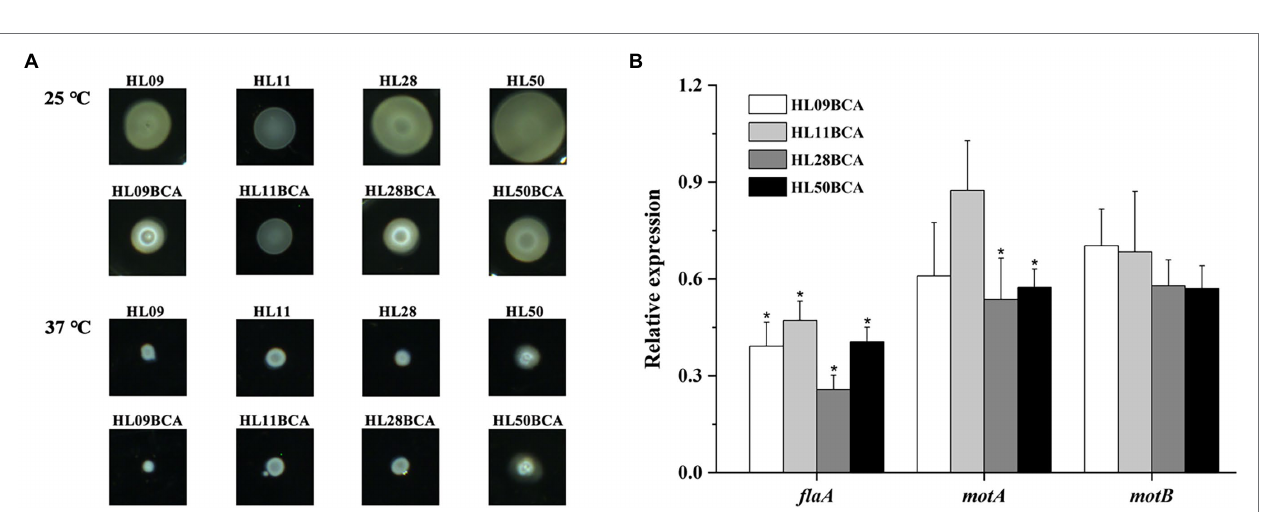
FIGURE 6 | (A) Swarming motility of the wild-type strains and the BC adapted strains of Listeria monocytogenes at 25 ° C and 37 ° C. (B) Relative expression levels of flagella gene ( flaA ) and motility-related genes ( motA and motB ). The asterisk indicates a value statistically different from that of the wild-type strain, with p <